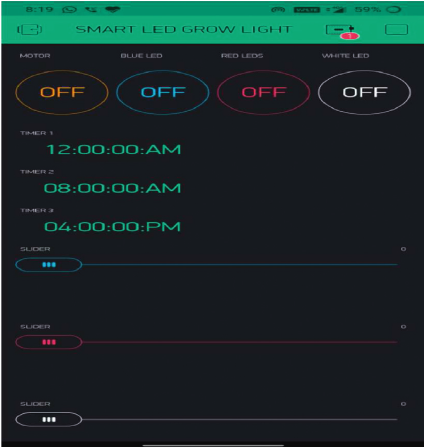
Figure 25: Simulation done in Blynk app.